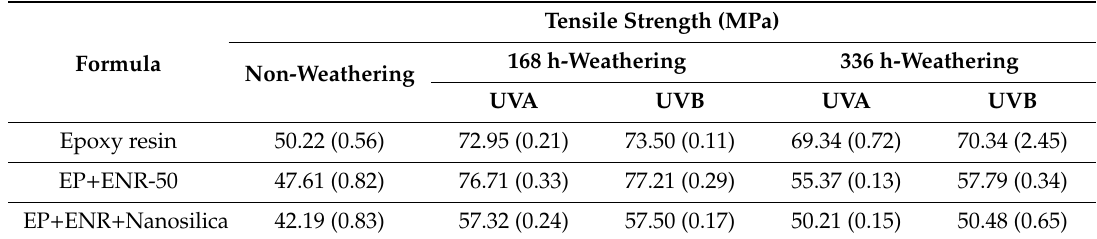
Table 1. The mean values of the tensile strength of the samples.